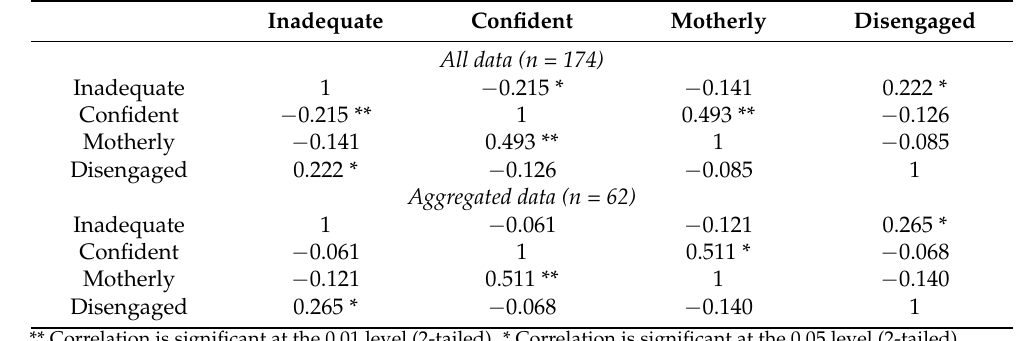
Table 3. Pearson correlations coefficients between the four CT subscales in the FWC-28, both on aggregated data and data from each session as separate measurements. Inadequate Confident Motherly Disengaged All data (n = 174)